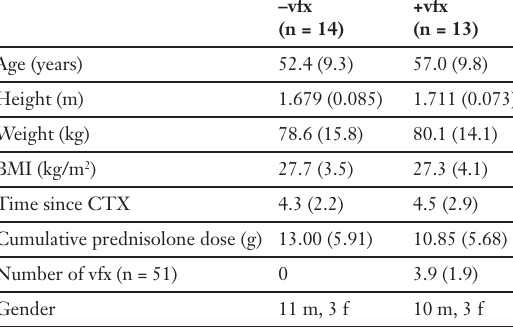
Baseline clinical characteristics.